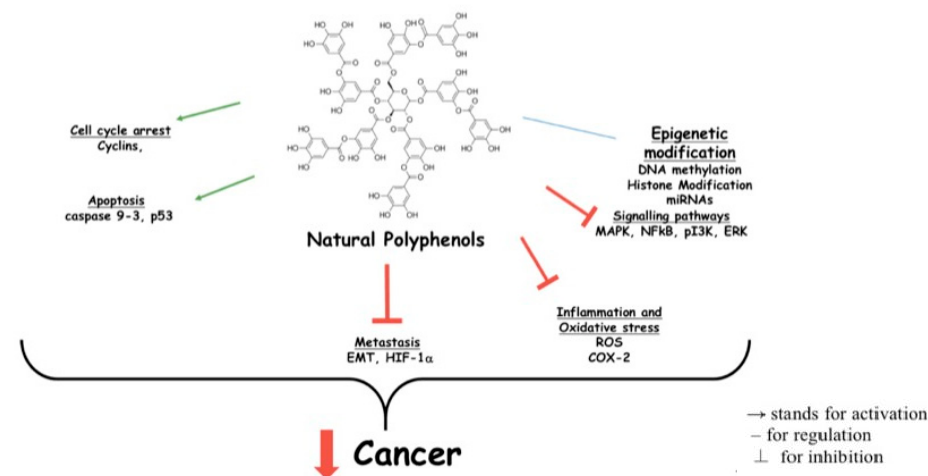
Figure 3. Anti-tumorigenic activities of polyphenols. MAPK: mitogen-activated protein kinase; NF κ B: nuclear factor kappa-light-chain-enhancer of activated B cells; PI3K: phosphatidylinositide 3-kinase; ERK: extracellular signal-related kinases; ROS: reactive oxygen species; COX: cyclooxygenase; EMT: epithelial mesenchymal transition; HIF-1 α : hypoxia-inducible factor 1-aplha.